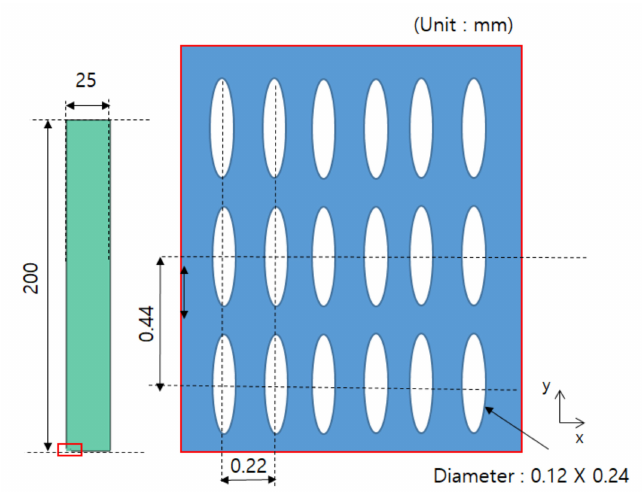
Figure 6. Dimension and distribution of elliptical pores (Reprinted from Ref.